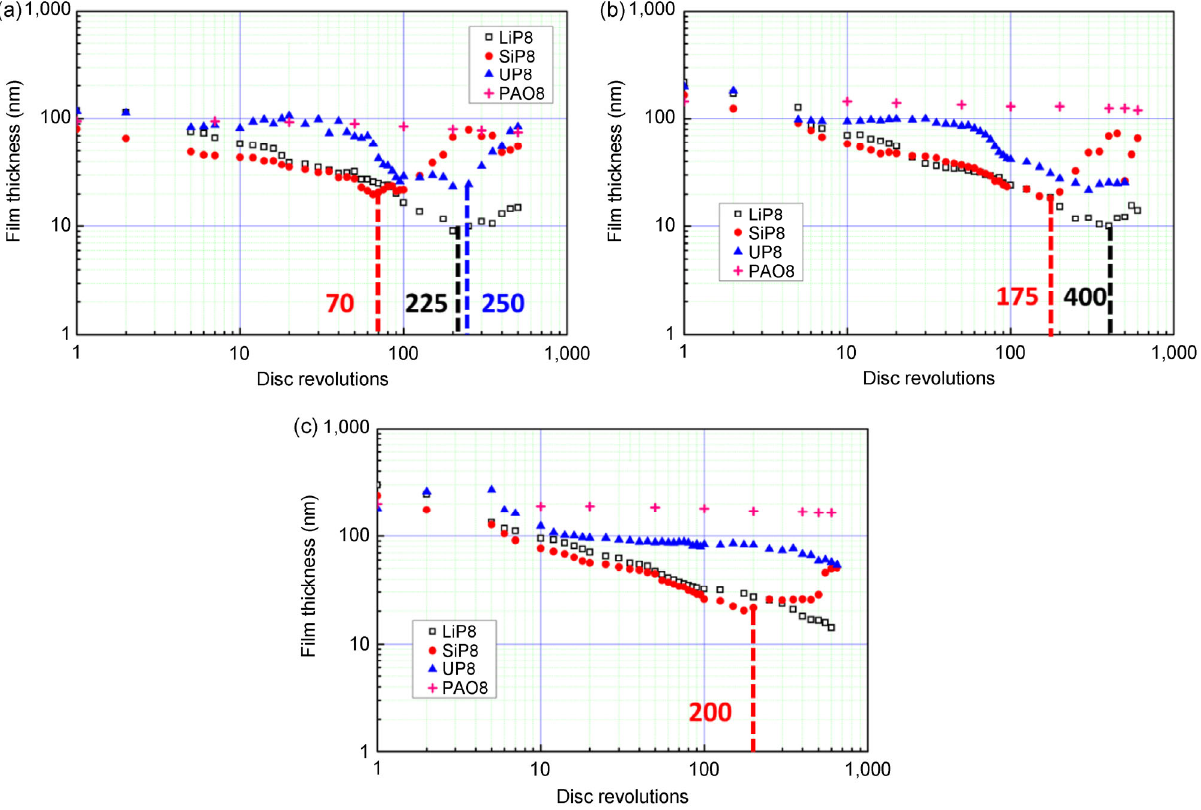
Fig. 1 Grease and base oil film thickness at (a) 100 mm/s, (b) 250 mm/s, and (c) 500